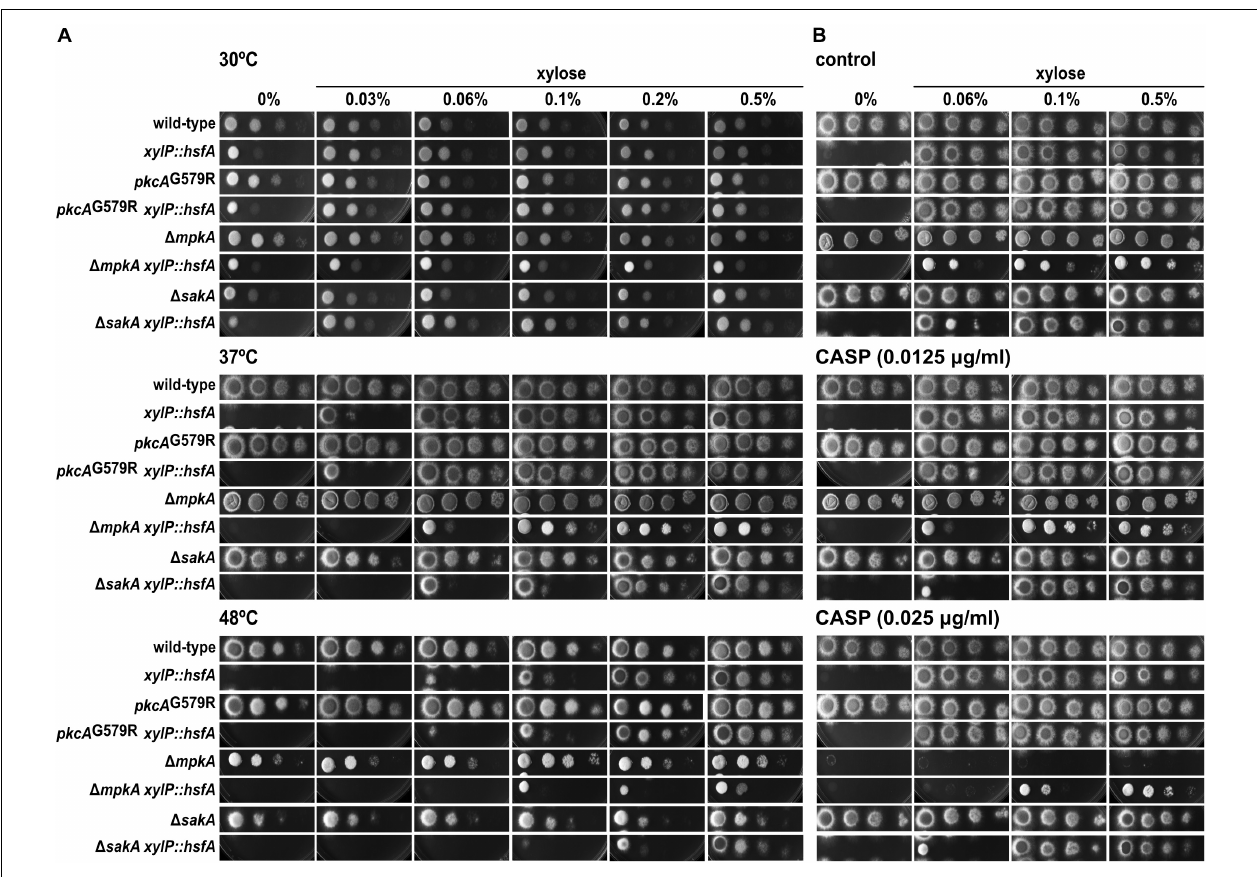
FIGURE 5 | hsfA genetically interacts with mpkA and sakA during temperature and cell wall stresses. Tenfold dilution series of conidia from the wild-type, xylP::hsfA , pkcA G 579 R , pkcA G 579 R xylP::hsfA , (cid:49) mpkA , (cid:49) mpkA xylP::hsfA , (cid:49) sakA , and (cid:49) sakA xylP::hsfA strains was inoculated into solid MM containing different concentrations of xylose. (A) Plates were incubated at 30 ◦ C, 37 ◦ C, or 48 ◦ C for 48 h. (B) 0.0125 µ g/ml and 0.025 µ g/ml of caspofungin (CASP) were used to induce cell wall stress and the plates were incubated at 37 ◦ C for 48